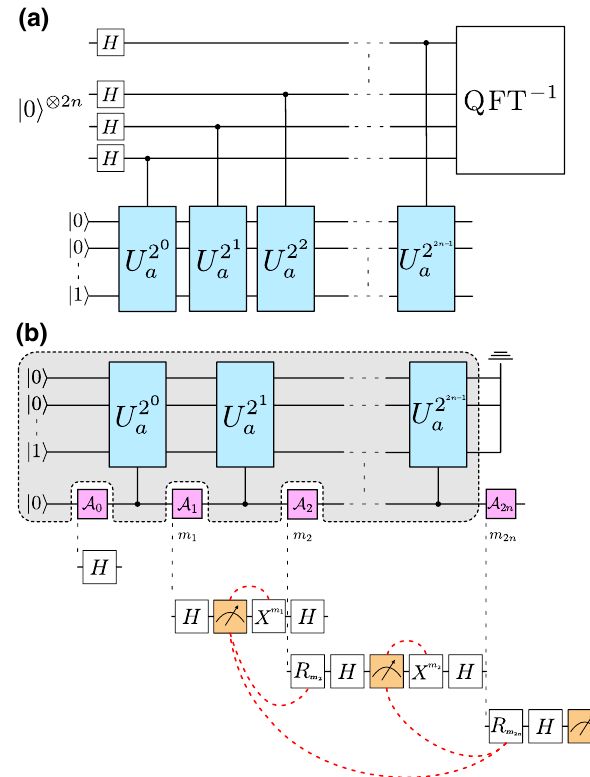
FIG. 3. Shor’s algorithm. (a) The order-finding circuit for Shor’s factoring algorithm of a n -bit integer as described in the text. The unitaries perform modular multiplication and collec- tively transform | x (cid:4) to | ( ax ) mod N (cid:4) . The inverse QFT, subse- quent measurement, and classical postprocessing give the period of the function f ( x ) = a x mod N . (b) Shor’s algorithm as a pro- cess tensor. The 2 n register is collapsed to a single control or “system” qubit using the one-controlled-qubit trick. The opera- tions A j correspond to the gates of the inverse QFT on a single is performed that depends qubit. At each time t j , a rotation R m j on all previous measurement results, followed by a measurement and reset X m j , as described in the text. The classical correlations between these operations are shown by the red dotted